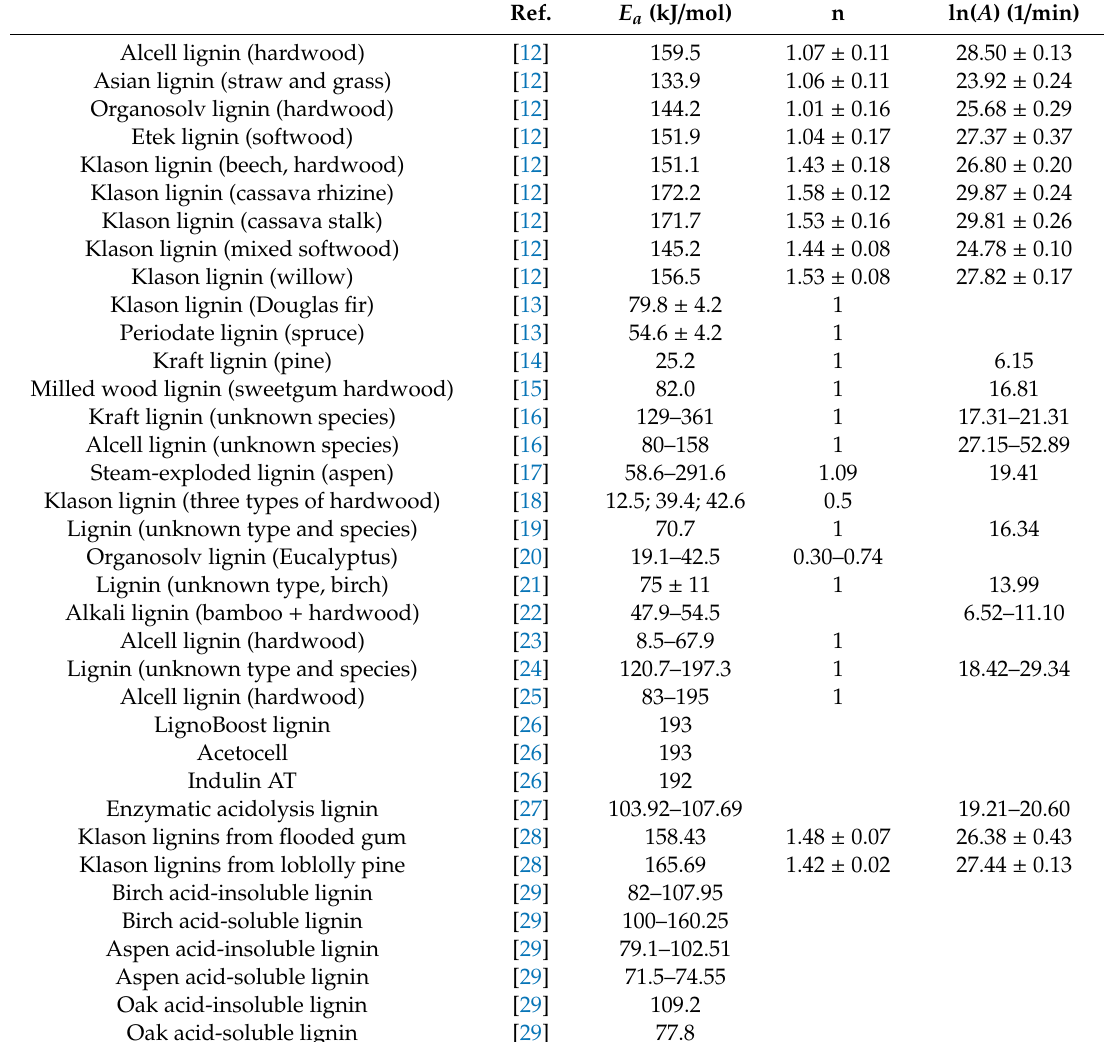
Table 1. Kinetic parameters derived for various types of lignin in previously published